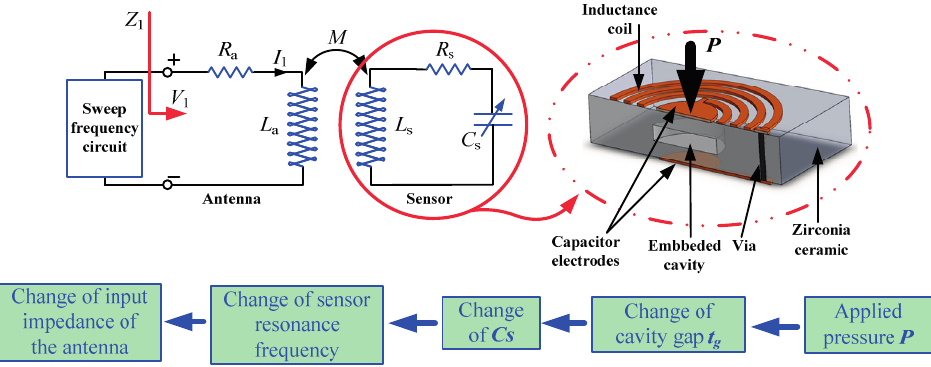
Figure 1. Measurement principle and structure diagram of the pressure sensor.